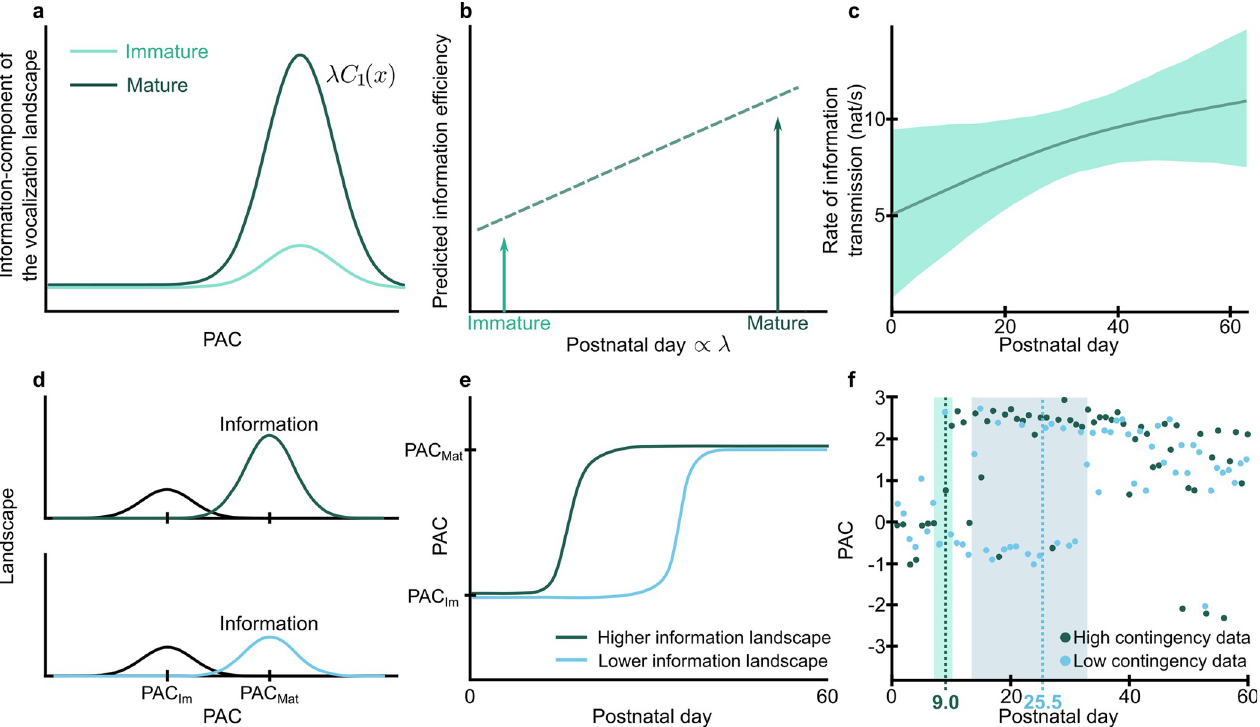
Fig 3. Information transmission efficiency is related to the mature component of the vocalization landscape. a. Schematic of how the predicted information component of the vocalization landscape, λ C 1 ( x ), varies from immature (smaller λ ) to mature phases (larger λ ) of development, being lower during the mature stage. λ is the parameter that controls the balance between landscapes. C 1 ( x ) is the component of the landscape which relevance increases during development. b. Expected increase of efficiency in information transmission given the increase in information landscape. c. Observed information transmission of marmoset infant calls throughout development. The shaded region represents a 95% confidence interval. d. Schematic of two situations with different information component of the landscape C 1 ( x ): the plot on the top represents a higher information landscape, the plot on the bottom represents a lower information landscape. The black line represents the energy component, C 0 ( x ), and is assumed to be constant in the two scenarios. e. Predicted vocal dynamics, measured by the optimal PAC, for the two scenarios, showing that higher information landscape predicts faster transition. f. Observed vocal dynamics from the feedback contingency manipulation setup in marmosets. Dashed lines represent transition day T high for high contingency data (dark green line) and T low for low contingency data (light blue line). T high < T low with p < 0.001.